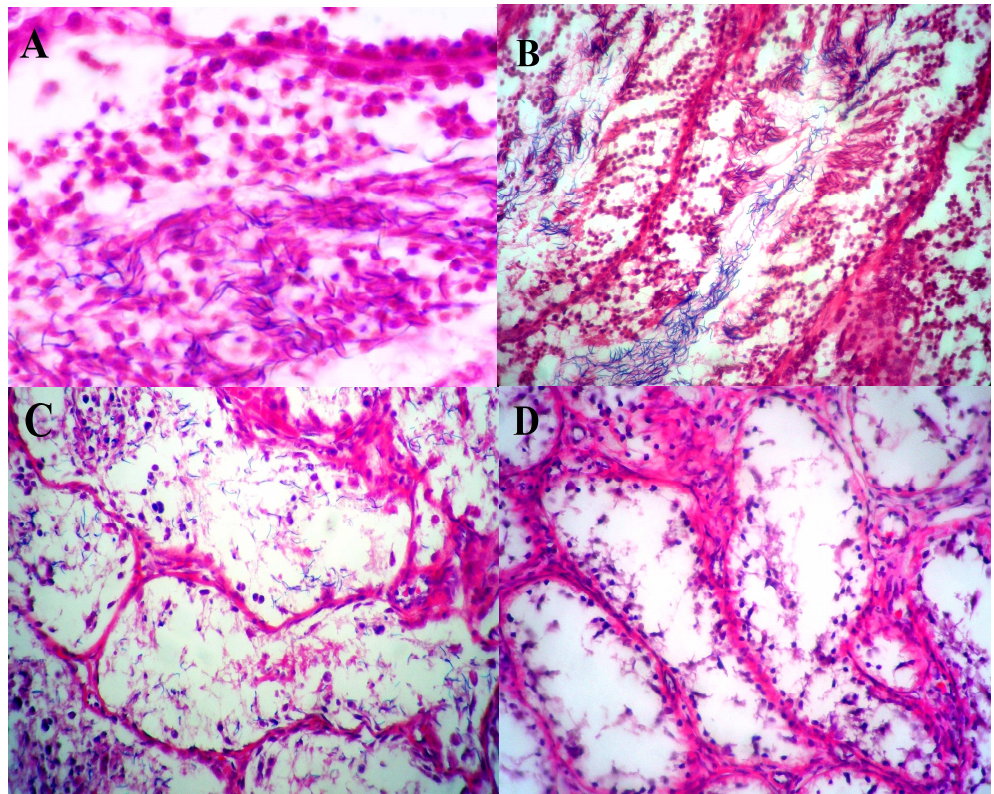
F IGURE 4. Seminiferous tubules of Teratoscincus bedriagai . Spermatogonia, spermatocytes, spermatids and sperms are abundant on April (A) and May (B). Seminiferous epithelial heights and tubule diameters increase on May; and testes regression with germinal epithelium reduces on July (C) and August (D). All slides are shown at 400× magnificence.